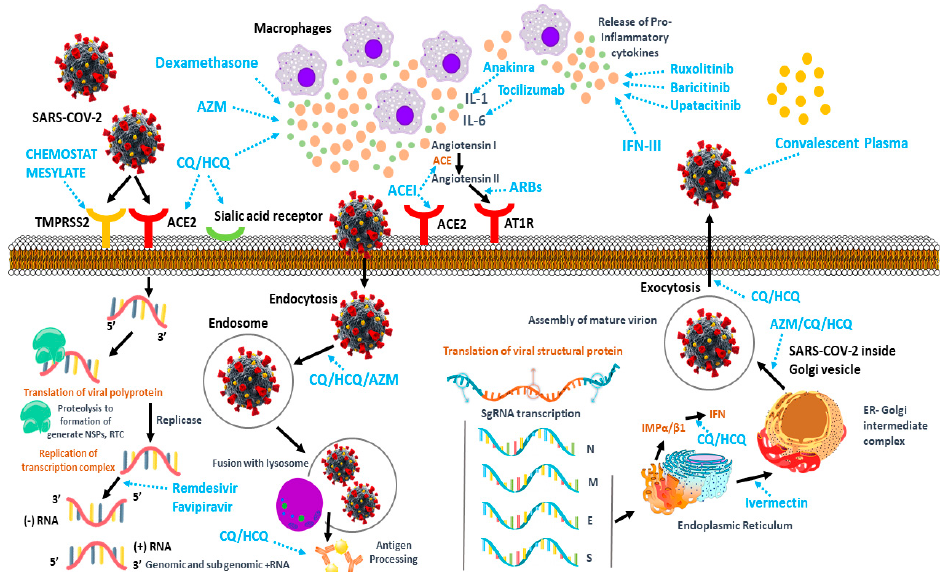
Figure 1. SARS-CoV-2 replication process and possible therapeutic targets (reproduced from [71]).